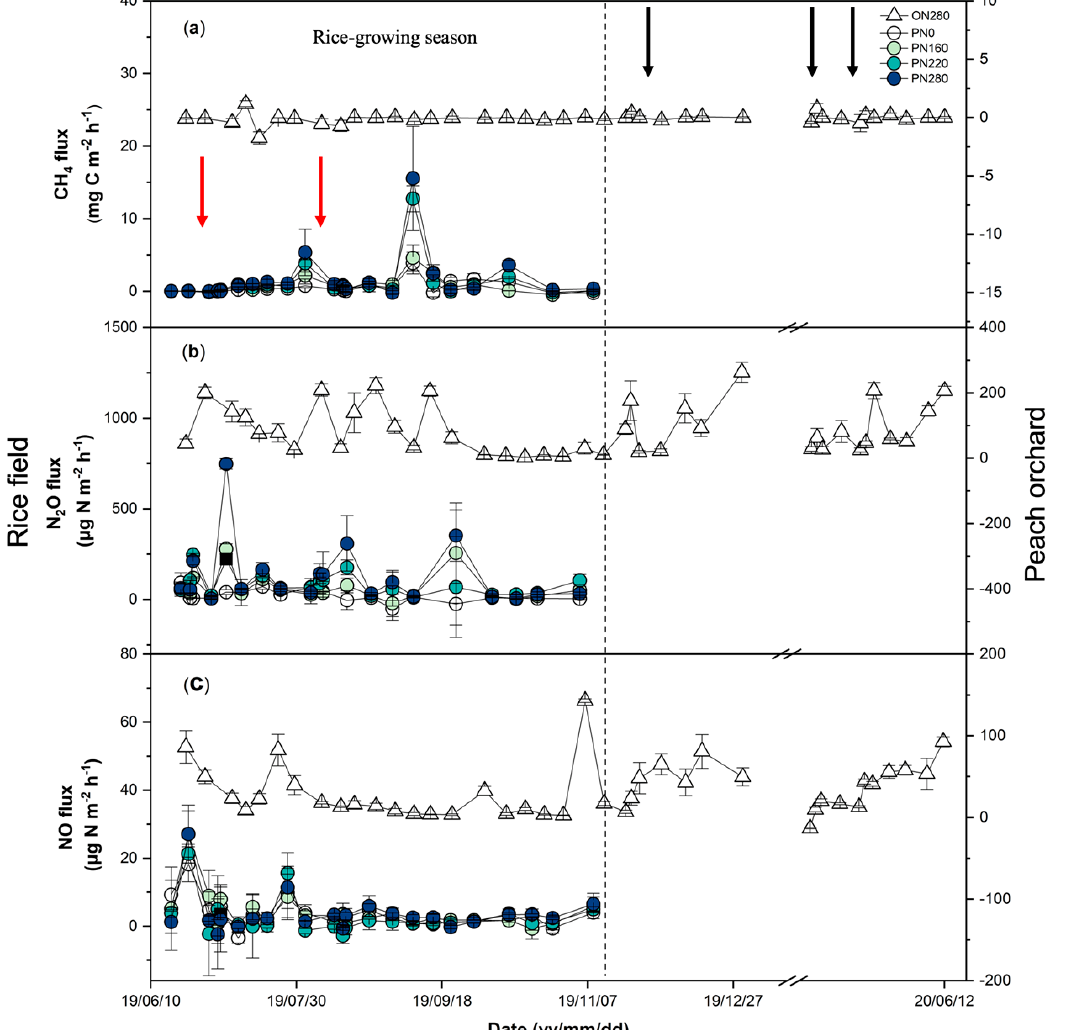
Figure 2 . The seasonal fluxes of soil CH 4 ( a ), N 2 O ( b ), and NO ( c ) in the rice and peach orchard fields under different fertilization treatments. The solid black line and gray shading indicate the fertilization time and irrigation period of the rice field, respectively. Values are mean ± SE ( n = 3). The orchard break (15 January to 23 April 2020) in the figure indicates no sampling due to the COVID-19 pandemic. The left y -axis is for the rice field, and the right y -axis is for the peach orchard. Table 2. Cumulative fluxes of CH 4 , N 2 O, NO, CH 4 plus N 2 O, and N 2 O plus NO for the rice-growing season and annual rice field and peach orchard, as well as direct emission factors (EF) of N 2 O, NO, and N 2 O plus NO for rice cropping systems. Data for the wheat growing season were obtained from the average emissions from conventional fertilizer treatments in previous rice–wheat rotation stud- ies in the same region. Values are means ± SE ( n = 3). Means that do not share a letter are statistically significantly different from each other ( p < 0.05).